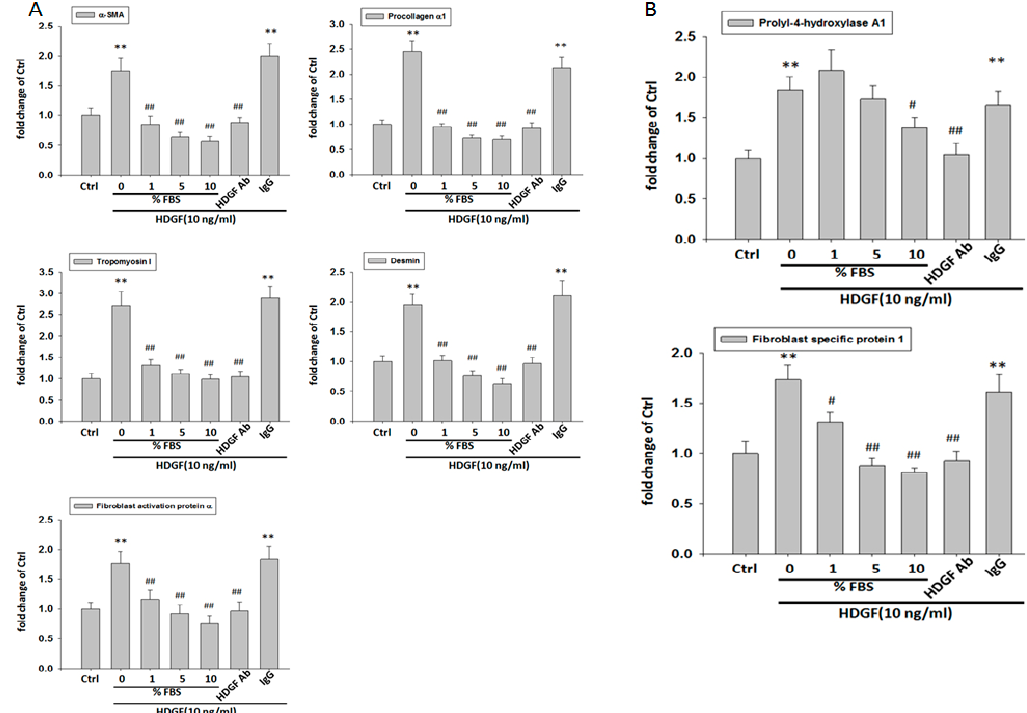
Figure 5. Serum and HDGF neutralizing antibody inhibits the expression of myofibroblast and fibroblast markers. HBMMSCs were treated with various concentration of FBS (0, 1, 5, 10%), or HDGF neutralizing antibody (HDGF-NAb; 1 µ g/ml) in the presence of HDGF (10 ng/ml). After 24 hours, the marker expression of myofibroblast ( A ) and fibroblast ( B ) was measured by RT q-PCR. * p < 0.05; ** p < 0.01 versus control (line 1); # p < 0.05; ## p < 0.01 versus only HDGF treatment (line 2) (mean ± SD, n = 3).